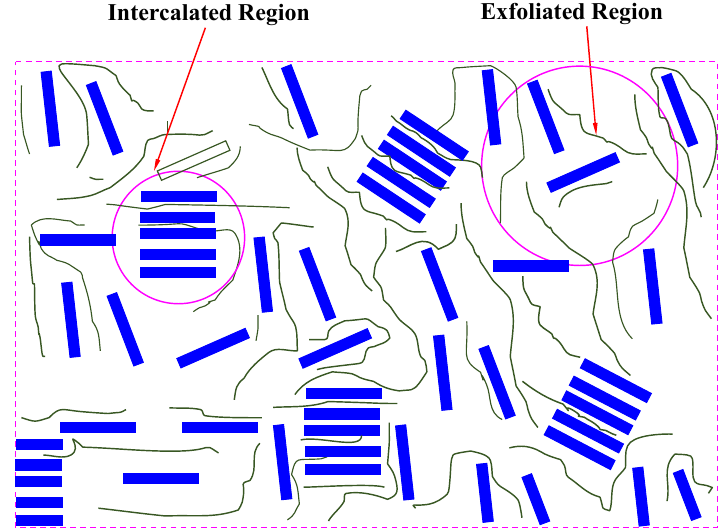
Figure 1. Schematic of intercalated and exfoliated clay particles in a polymeric matrix.